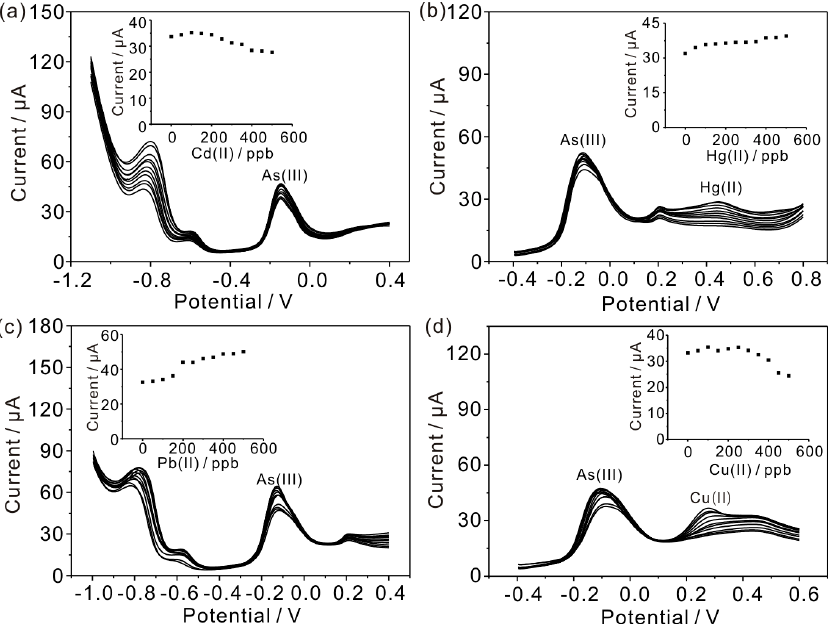
Figure 5. SWASV responses of the MnFe 2 O 4 /Au hybrid nanospheres modified GCE containing 50 ppb As(III) in the presence of Cd(II), Hg(II), Pb(II), and Cu(II) over a concentration range of 0 to 500 ppb, respectively. (Insets in panel a, b, c, and d are the corresponding peak currents toward 50 ppb As(III) over a concentration range of 0 to 500 ppb of interfering ions.) Electrochemical stripping conditions are identical to those in Figure 4.